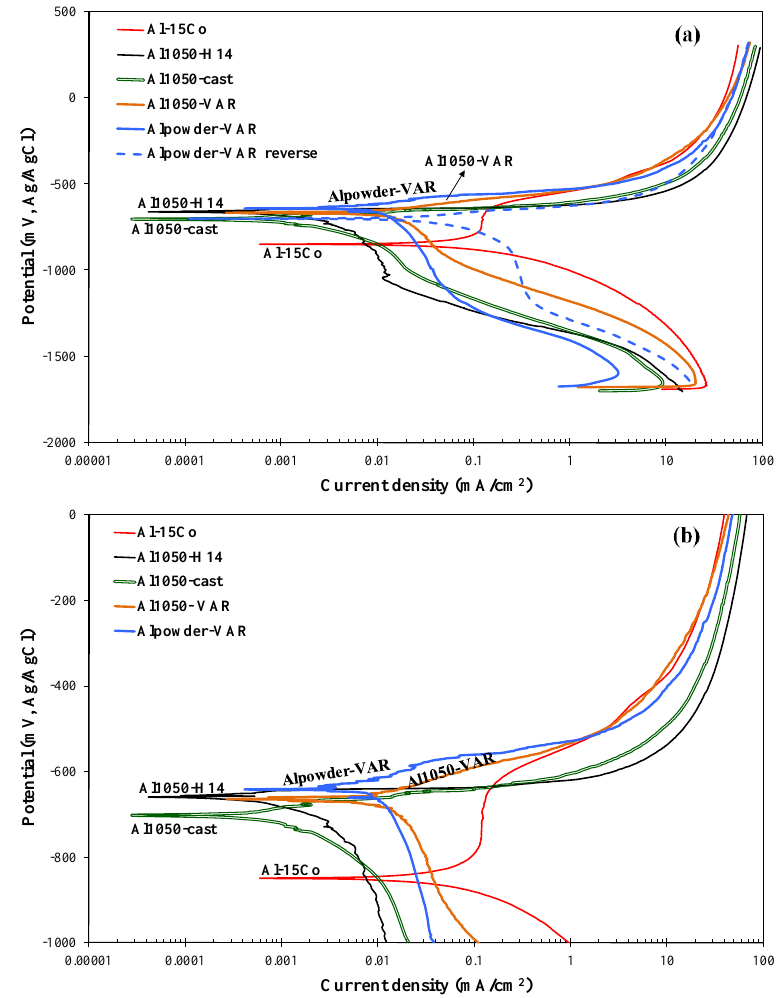
Figure 5. Potentiodynamic polarization performance of CP‐Al produced by VAR of CP‐Al powder (Alpowder‐VAR), VAR of Al1050 sheet (Al1050‐VAR), casting of Al1050 (Al1050‐cast), cold rolling (Al1050-H14) and Al‐15 wt.% Co produced by VAR (3.5 wt.% NaCl, 25 °C); ( a ) full view; ( b ) magnified view at a selected range of potentials.